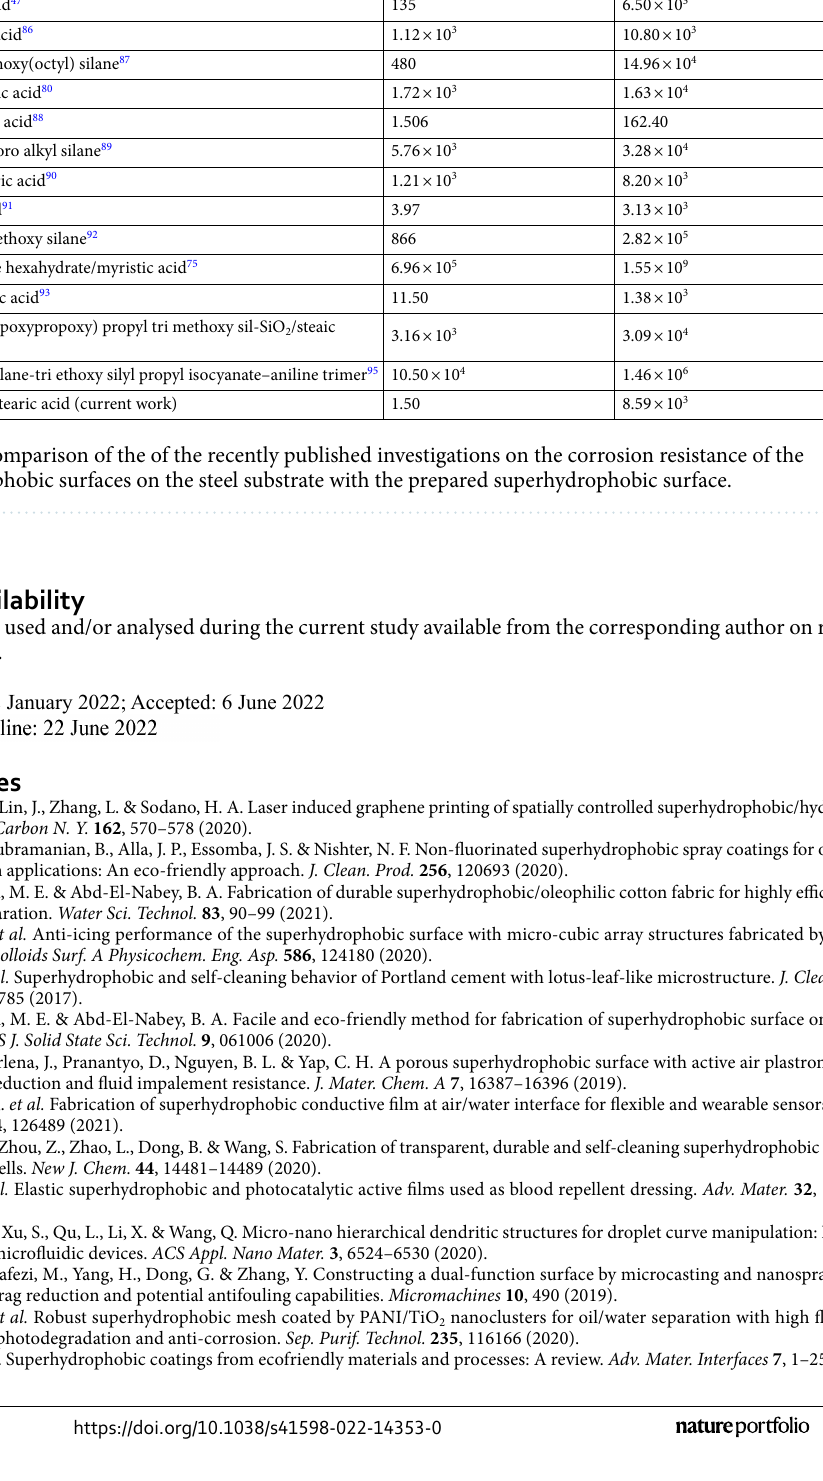
Superhydrophobic